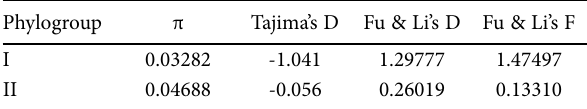
Table 2. Representative parameter estimates for the Algerian GLRaV-1 phylogroups.